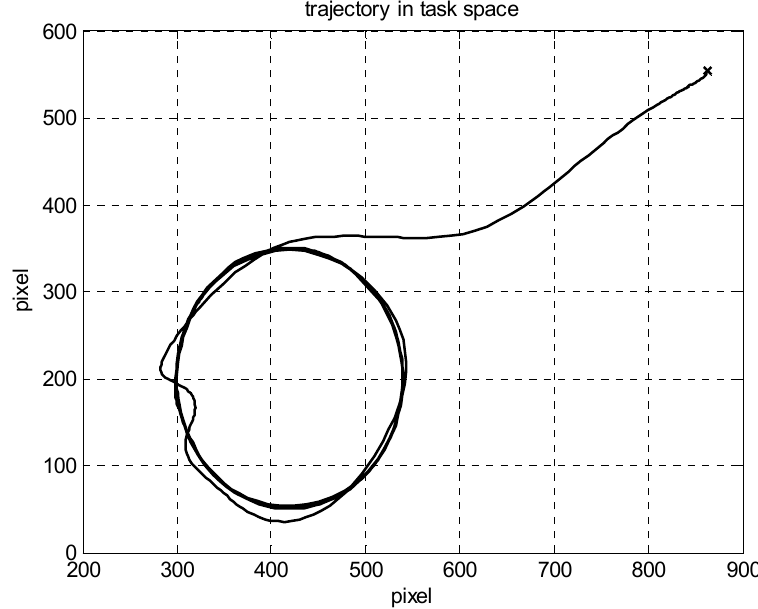
Figure 2. Trajectories in the task space.